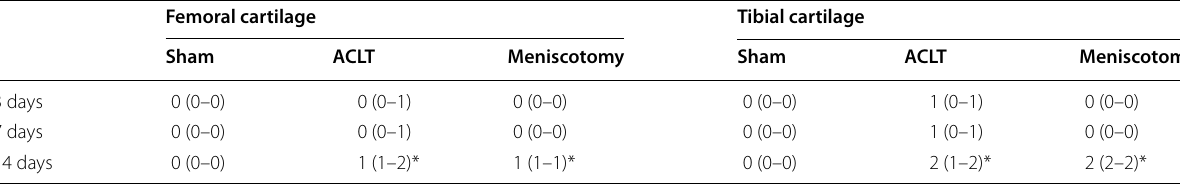
Table 2 Scanning electron microscopy (SEM) grading of the cartilage damage Femoral cartilage